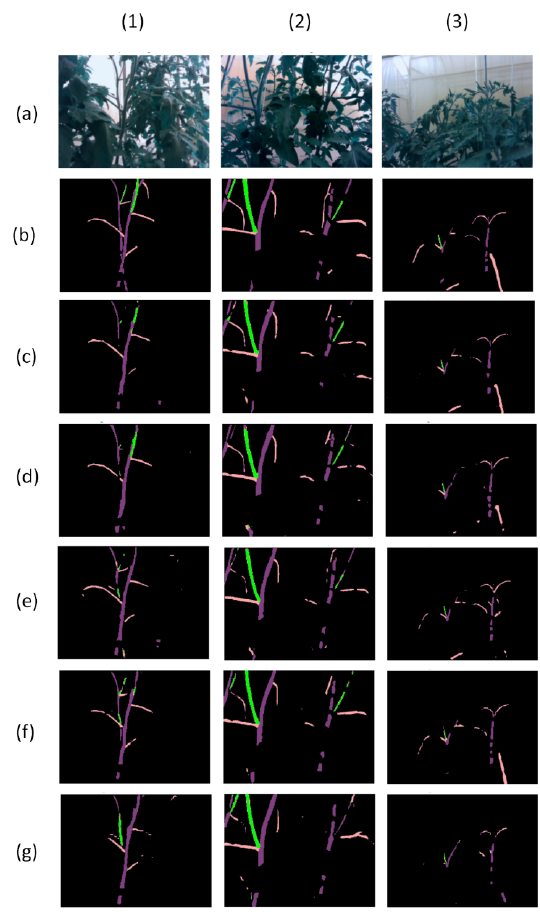
Figure 11. Three examples (1–3) with 6 model results. Row ( a ) is the RGB images, row ( b ) is the ground truth labels, and row ( c – g ) are the results of the proposed neural network, Version 2, Version 1, DeepLab V3, Fast-SCNN models.